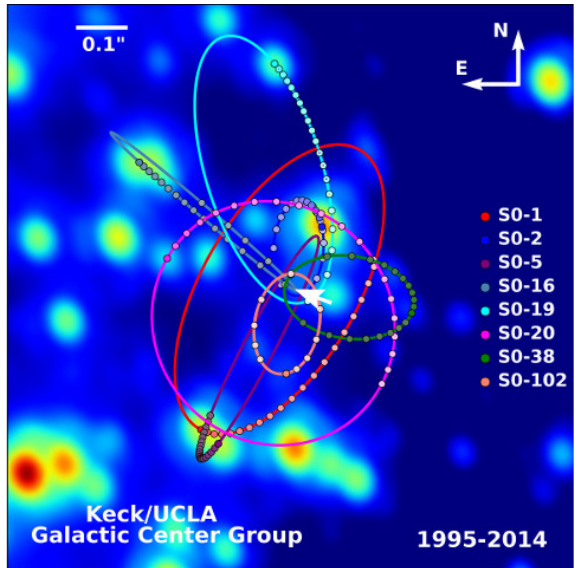
Figure 1. There exist indications that the central zone of our galaxy contains a compact, possibly rotating, object with mass ∼ 4 × 10 6 M (cid:12) . This super-massive object, thought to be a black hole, exerts strong influence on the dynamics of nearby stars. (See, for example, [1,2], as well as [3].) The image (from [1] These images/animations were created by Prof. Andrea Ghez and her research team at UCLA and are from data sets obtained with the W. M. Keck Telescopes) shows tracks of the brightest stars near the center of the Milky Way. The image presented here was obtained by the UCLA research team based on data obtained by the teams at the W.M. Keck Observatory over the span of two decades. The orbits plot as dots the star positions at one-year intervals. The central arrow (added by us) points to the presumed location of the super-massive black